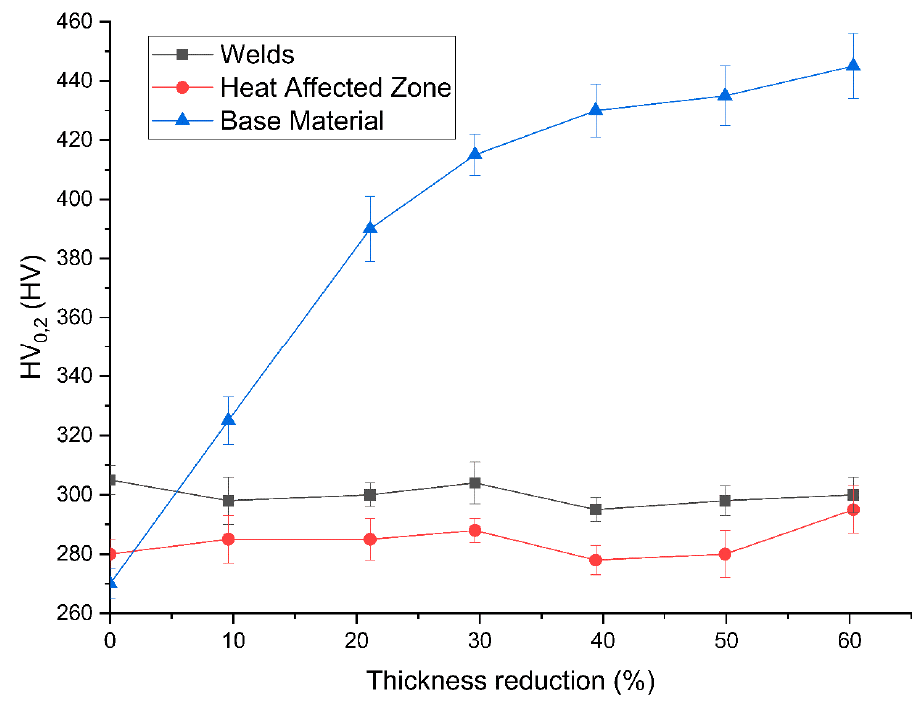
Figure 7. Evolution of hardness with respect to thickness reduction for the welds, the HAZ and the base material.